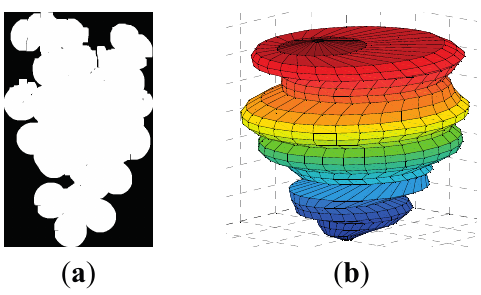
Figure 2. ( a ) Example segmented image of a cluster of grapes; ( b ) Representation of the solid of revolution of the cluster of grapes estimated from the segmented image.